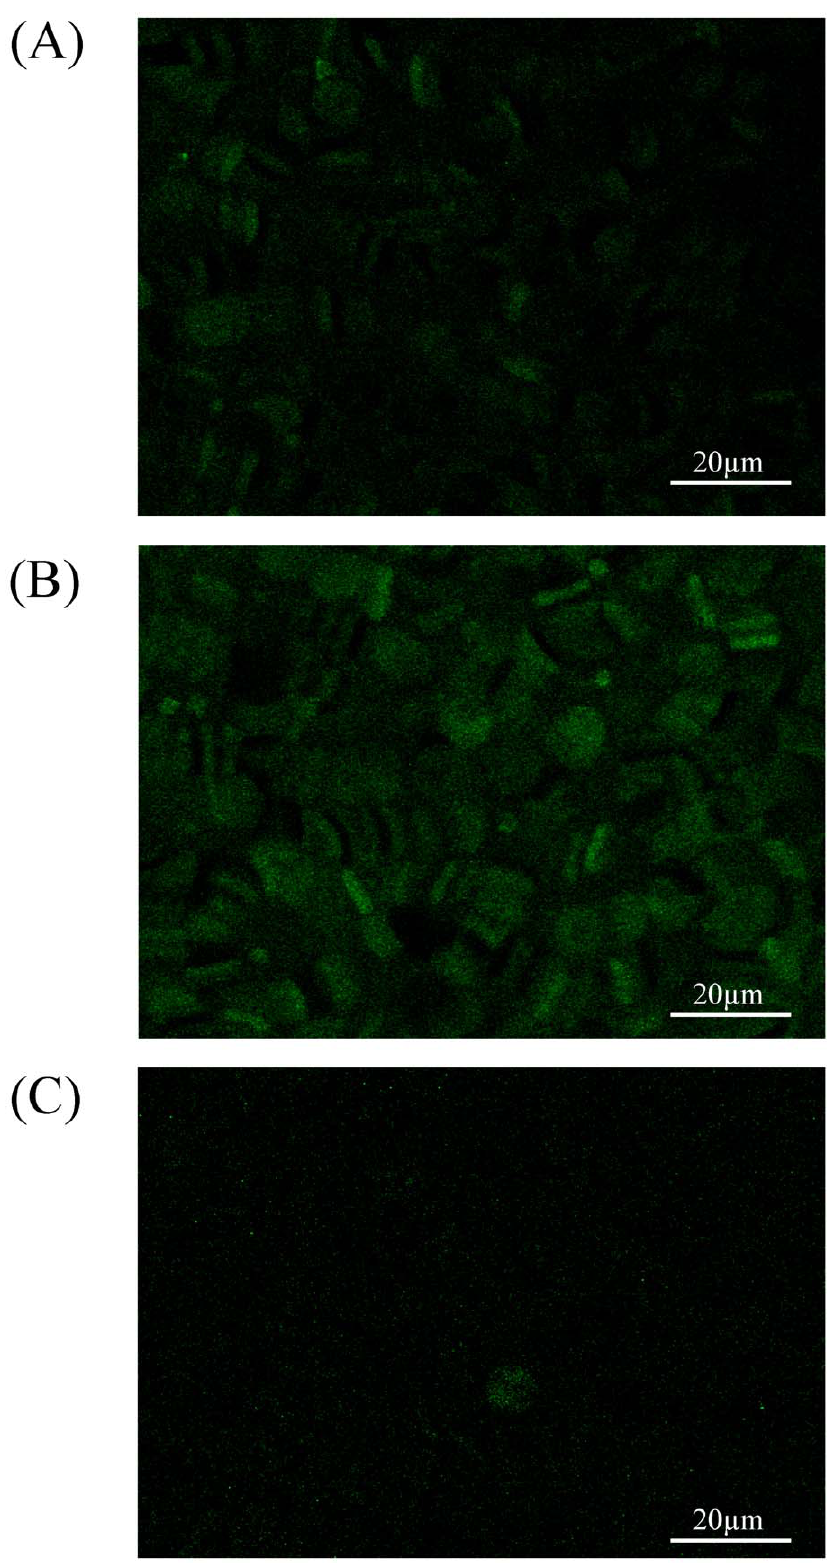
Figure 6. NO-generation in human RBCs after exercise. (A) DAF fluorometry revealed no detectable NO-generation Pre AMRT. (B) Strong NO generation signals were observed Post AMRT. (C) The NO generation was strongly reduced after AMRT by the PI3 kinase specific inhibitor wortmannin (c=10 m M). Bar, 20 m m.